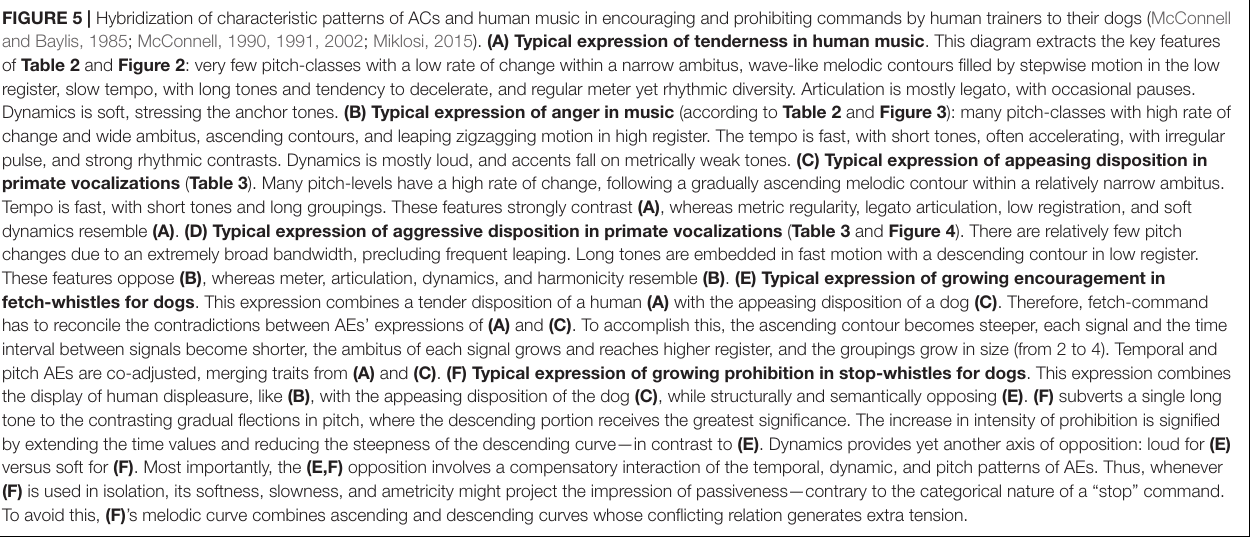
while humans benefited from animal produce. They both had